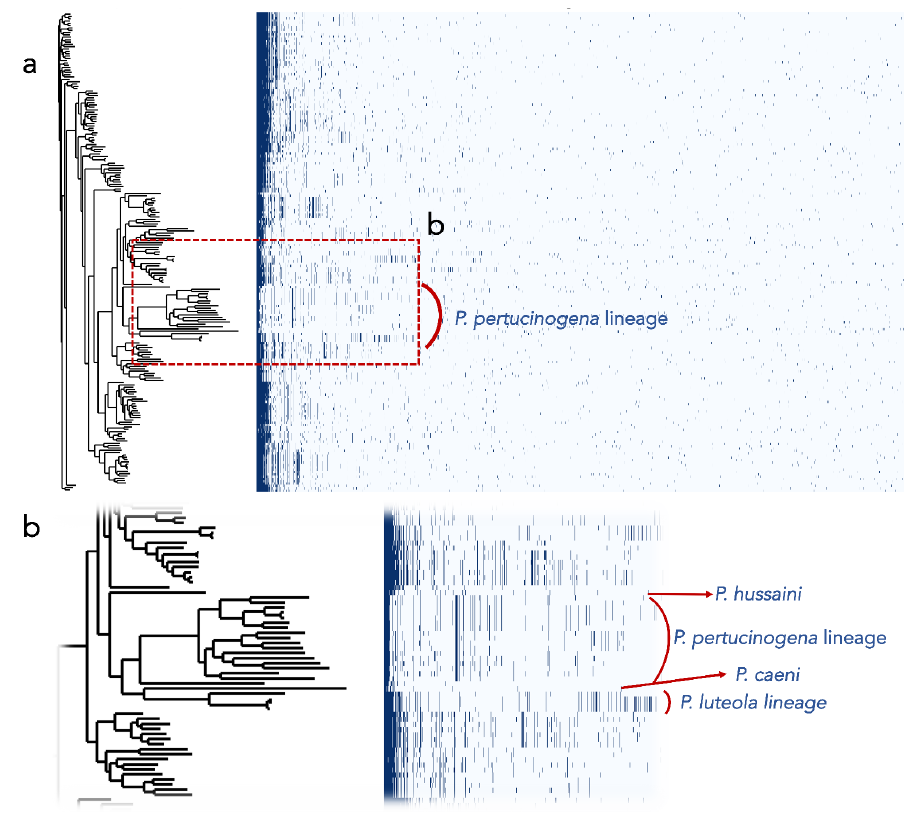
Figure 3. ( a ) Presence/absence profiles of the protein clusters of the genomes of the Pseudomonas type strains. The phylogenetic tree was built with UBCG. ( b ) Screen enlargement showing the protein profiles of the main lineages that are divergent from the other genomes of Pseudomonas .